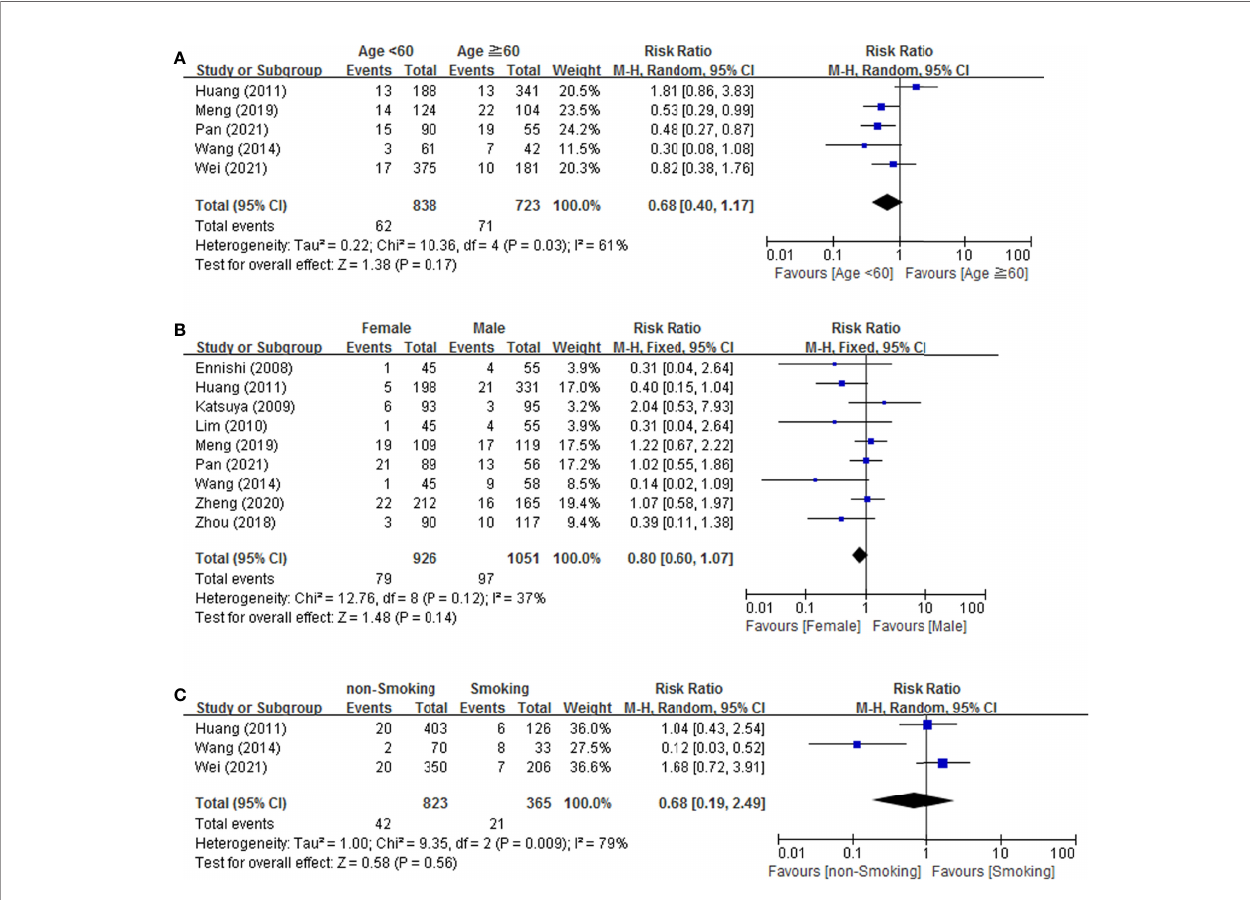
FIGURE 2 | Forest plot of studies among patient-related risk factors associated with IP development. (A) Age. (B) Gender. (C) Smoking.